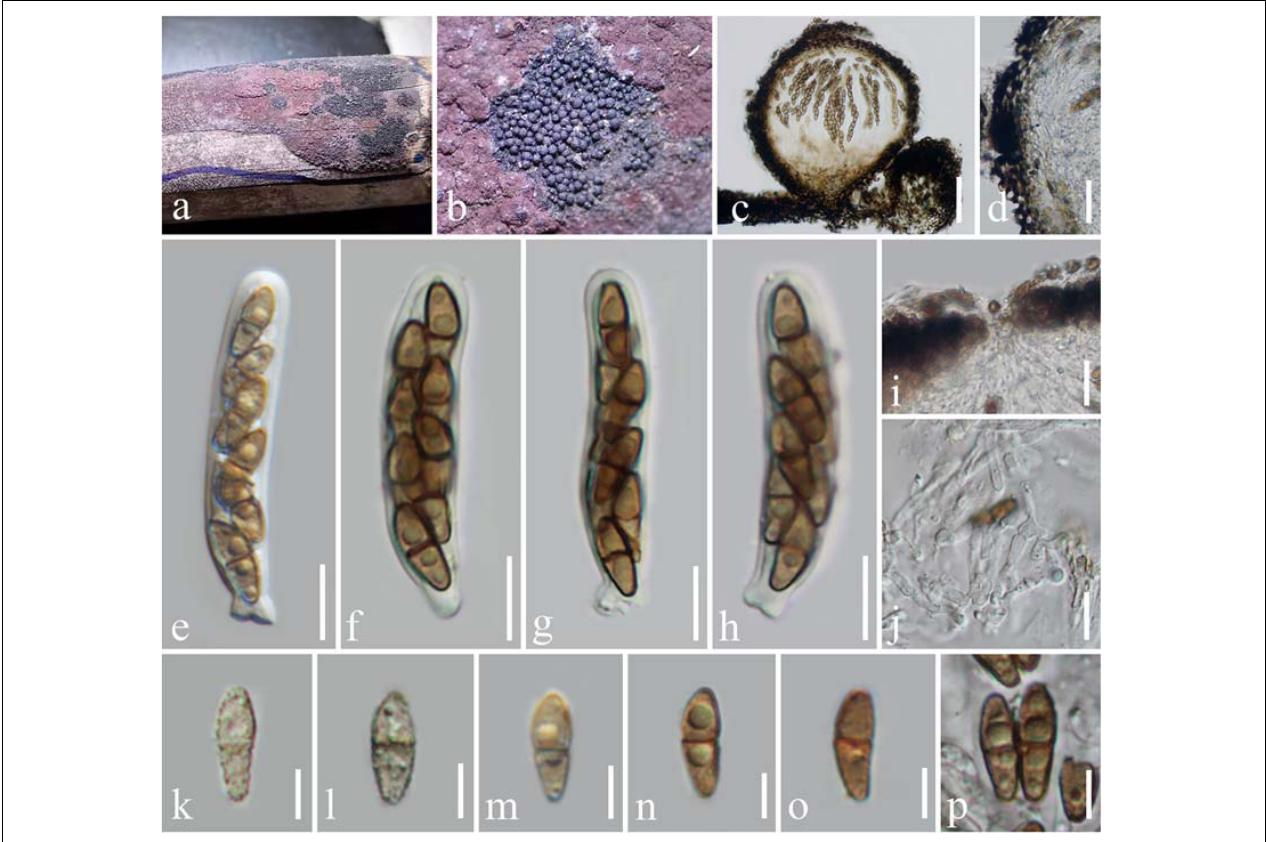
FIGURE 2 | Immotthia bambusae (KUN-HKAS 112012, holotype). (a,b) Appearance of hypostromata on Hypoxylon sp. associated with dead bamboo culms. (c) Vertical section of ascoma. (d) Peridium. (e–h) Asci. (i) Pore-like ostiole. (j) Pseudoparaphyses. (k–p) Ascospores. Scale bars: (c) = 50 µ m, (d) = 20 µ m, (i) = 15 µ m, (e–h,j) = 10 µ m, and (k–p) = 5 µ